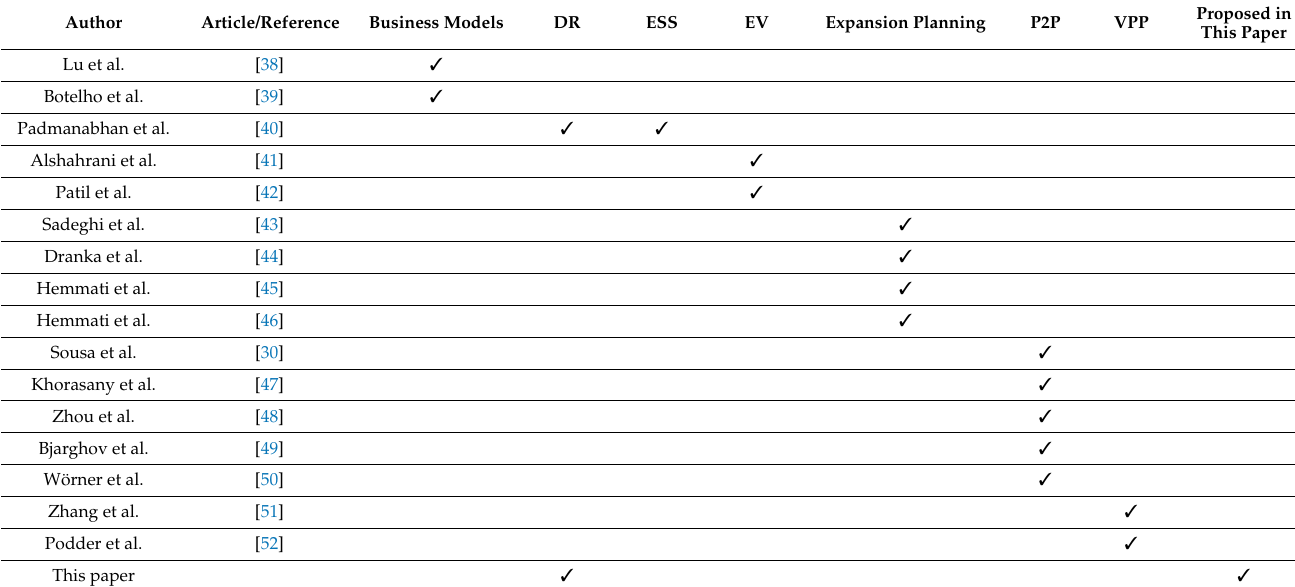
Table 1. Sample of review articles preliminarily found in the WoS and SC